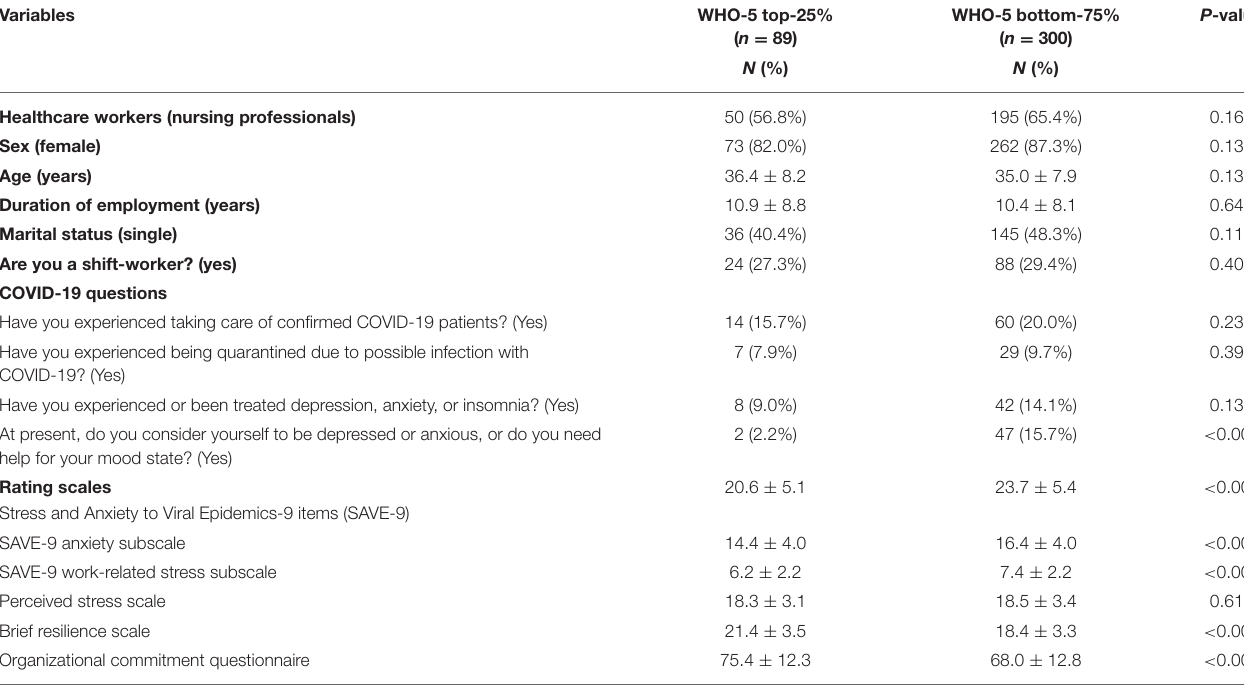
TABLE 3 | Comparison of demographic variables and rating scale scores between the low and high QOL groups ( N = 389).